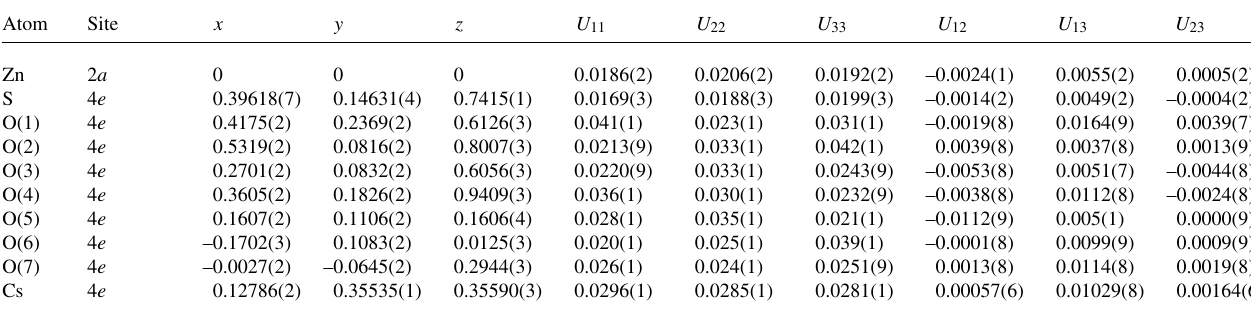
Table 18. Atomic coordinates and displacement parameters (in Å 2 )